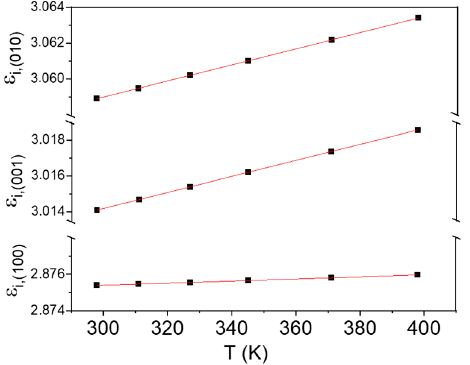
Figure 3. Anisotropic permittivity as a function of the temperature in the RT—400 K range. Table 1. T-dependent dispersion relations derived from ellipsometry measurements for (100), (010) and (001) directions.